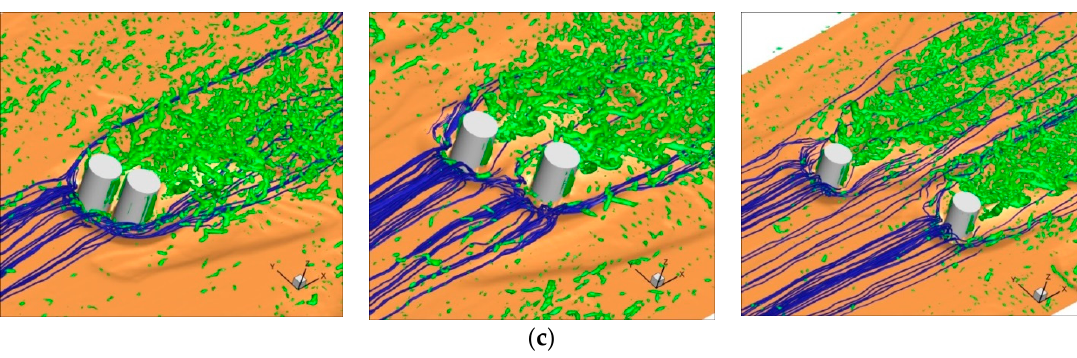
Figure 4. Instantaneous isosurface of Q -criterion on equilibrium bed at different alignment angles of two cylinders with three spacing ratio ( s / D = 1.25 ( Left ); s / D = 2.5 ( Middle ); s / D = 1.25 ( Right )): ( a ) α = 0 ° ; ( b ) α = 30 ° ; ( c ) α = 60 ° .